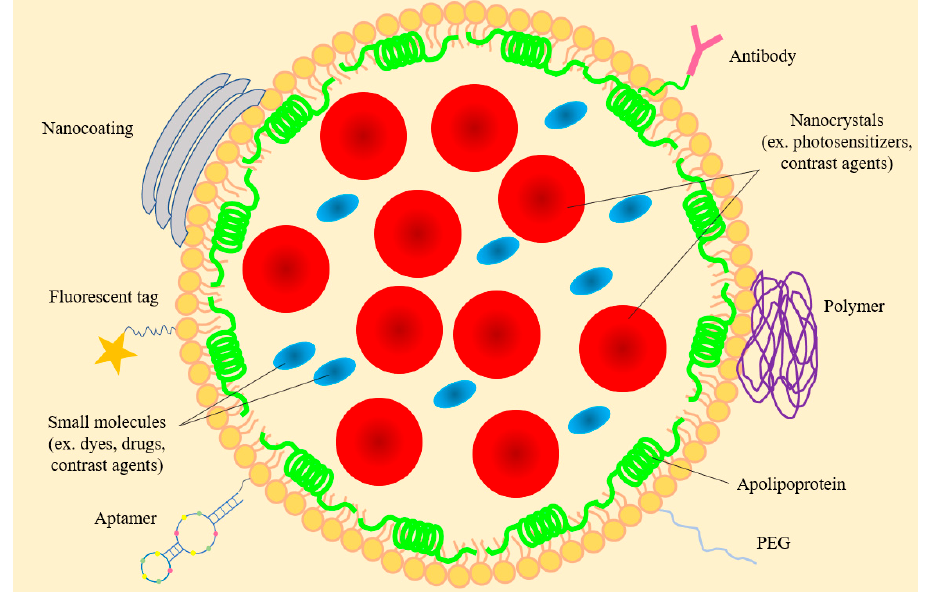
Figure 5. Applications of rHDLs as transport vehicles. rHDLs can serve as nanovehicles for transporting hydrophobic, amphipathic, and hydrophilic substances. The surface of rHDLs can be conjugated with antibodies or aptamers / nucleic acids for enhancing targeted delivery or modified with coating materials and polymers for extending circulation time inside the body.